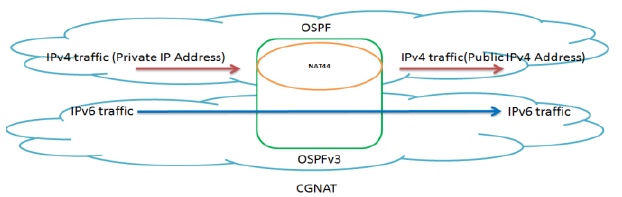
Fig. 10. Routing table size test environment